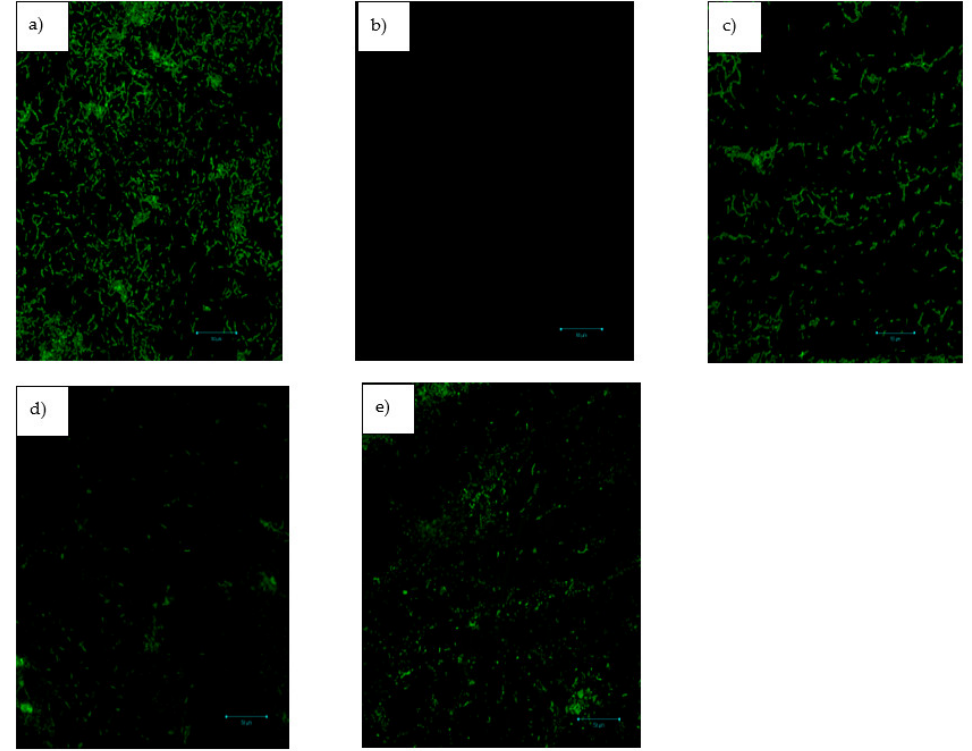
Figure 6. Confocal laser scanning micrograph ( × 500) of ( a ) 2% DMSO, ( b ) azithromycin, ( c ) cin- namaldehyde, ( d ) AGSUN 5102 CLP, and ( e ) AGSUN 5106 CLP.